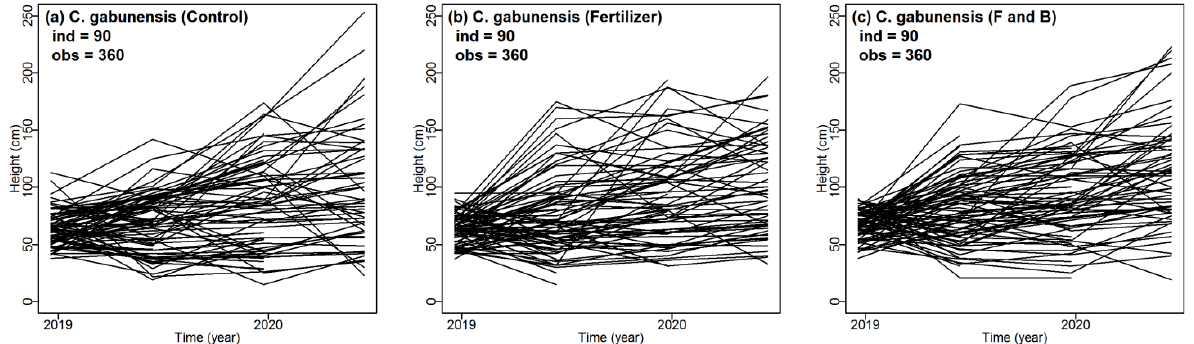
Figure 3. Height growth trajectory related to the installation date (between 2018 and 2020) for each seedling of C. gabunensis in logging gaps according to treatment; ( a ) control seedlings, ( b ) seedlings with fertilizer and ( c ) seedlings with fertilizer and biochar (F and B). Number of monitored seedlings (ind) and total number of measurements (obs) are given for each treatment. The discontinuous height trajectory for several seedlings is due to stem break events.